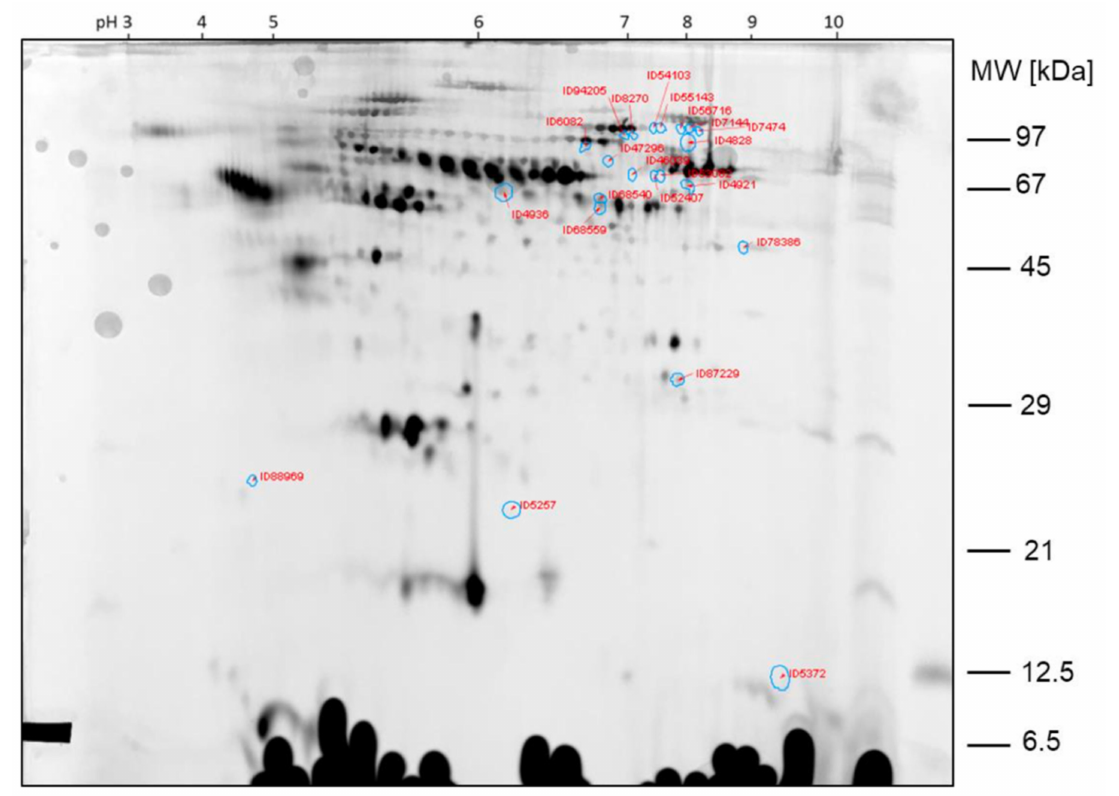
Figure 3. Comparison 1: Spots found >2-fold higher expressed in